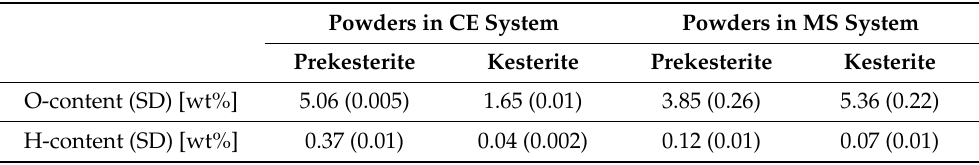
Table 2. The oxygen (O) and hydrogen (H) contents directly determined in prekesterite and kesterite nanopowders prepared in the CE and MS precursor systems. Standard deviations (SD) of the determinations are shown in